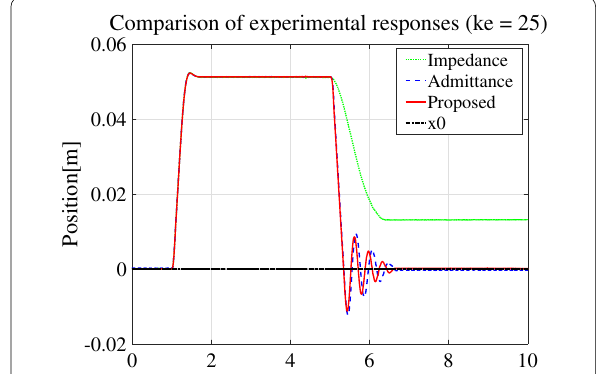
Fig. 9 Transient response of displacement of the control object (ke